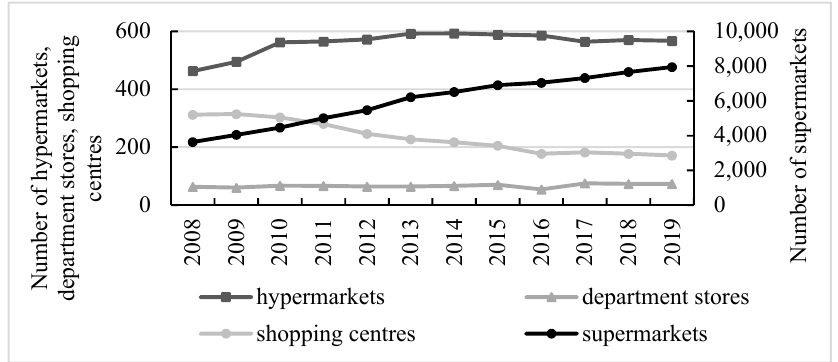
Figure 4. Number of large-format shops in Poland in 2008–2019. Source: own elaboration based on data from the Local Data Bank.